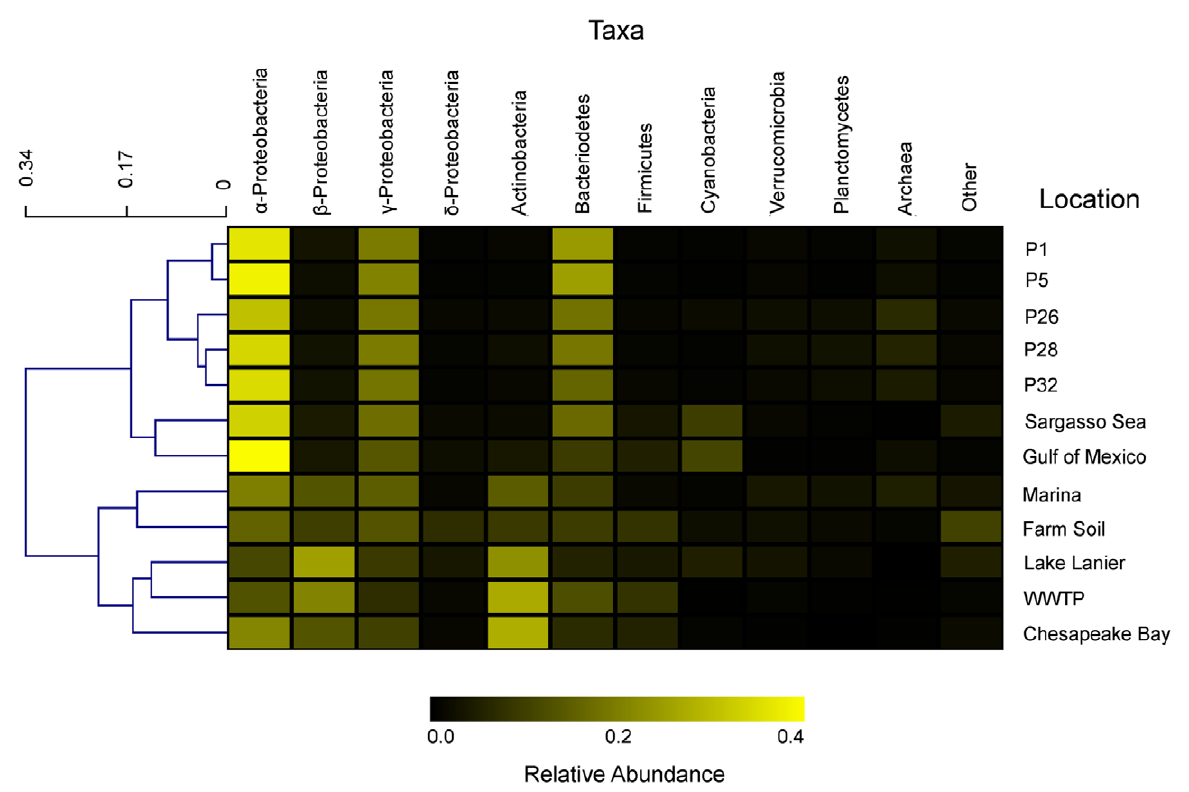
Figure 2. Relative abundance of major taxonomic groups in the Puget Sound samples and other selected metagenomes. Taxonomic groupings were based on BLASTX comparison to the NCBI taxonomy using MG-Rast [39] and $ 50% identity and an alignment length $ 50 amino acids. The ‘other’ category includes bacteria taxa present in , 1% of sequences in all samples, eukaryotes and viruses. Shading is proportional to the relative abundance of each taxon within a metagenome. The cladogram was displayed using hierarchical clustering and the Euclidian distance metric. See Materials and Methods for references describing the additional metagenomes used for comparison. The open Sound locations cluster with other more saline environments including open and coastal ocean samples while the Marina and WWTP effluent samples cluster within a larger clade containing other freshwater and freshwater-impacted metagenomes.